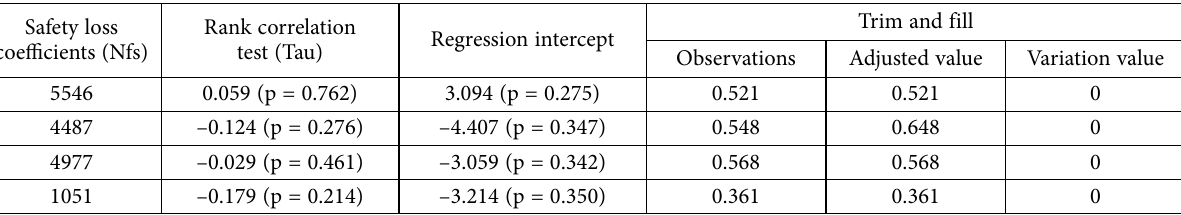
Table 3. The test value of publication deviation